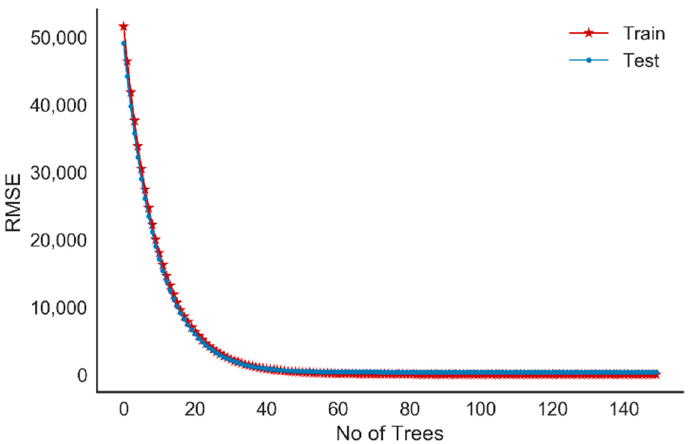
Figure 11 . Learning curve for the XGBoost regressor.